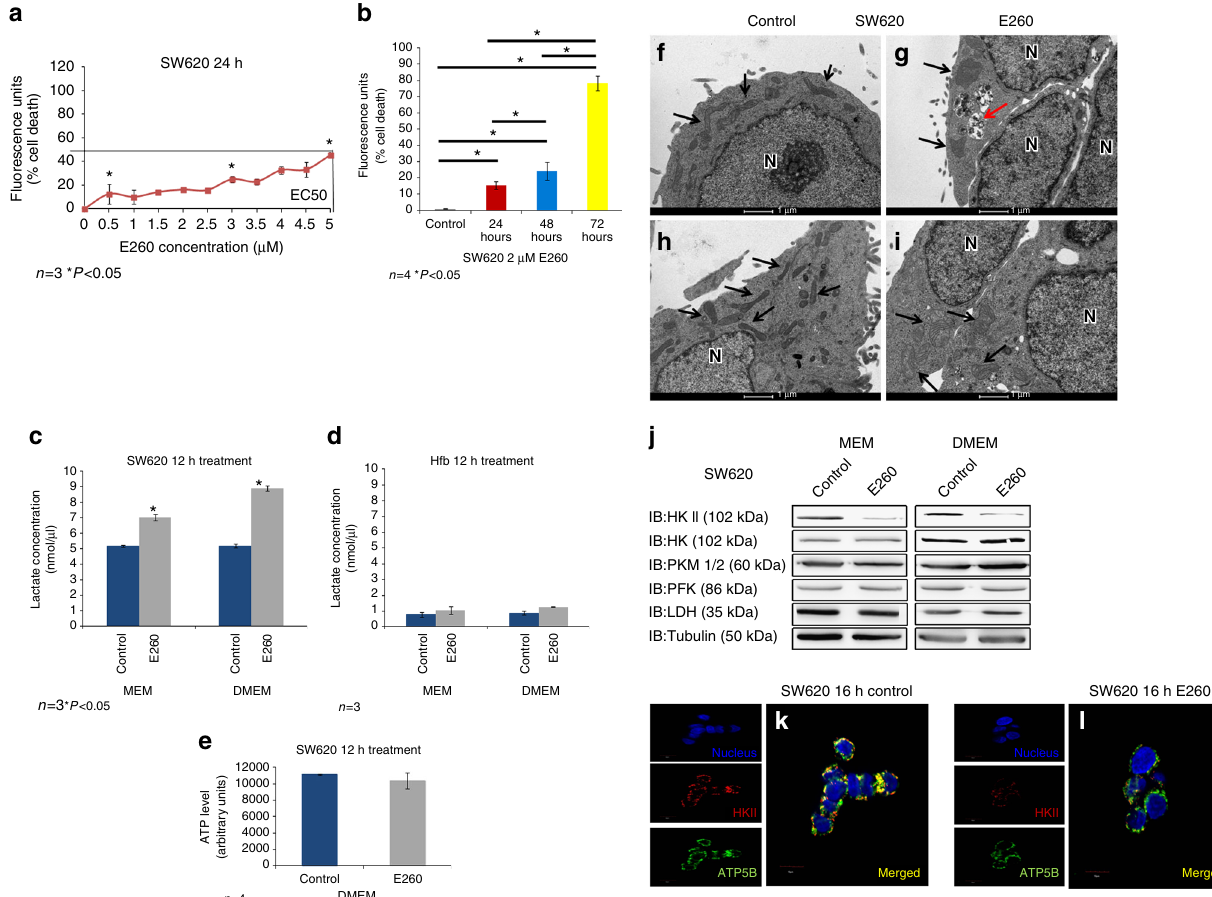
Fig. 6 Upregulated glycolysis and delayed onset of death in SW620 cells treated with E260 under high glucose conditions. a Death of SW620 cells grown in DMEM and treated with increasing concentrations of E260; n = 3, ± SE. b Death of SW620 cells grown in DMEM and treated with 2 µ M E260 for different periods of time; n = 4, ± SE. c Lactate levels secreted by SW620 cells grown either in MEM or DMEM and treated with control vehicle ( blue ) or 2 µ M E260 ( gray ) for 16 h. d Lactate levels secreted by Hfb grown either in MEM or DMEM and treated with control vehicle ( blue ) or 2 µ M E260 ( gray ) for 16 h. e ATP content in SW620 cells grown in DMEM and treated with control ( blue ) or 2 µ M E260 ( gray ) for 12 h; n = 4, ± SE. f – i TEM analysis of SW620 cells grown in DMEM and treated with control vehicle f , h , or 2 µ M E260 g , i for 24 h. Black arrows depict mitochondria. Red arrow points to autophagosomes. Bars represent 1 µ m. N nucleus. j Protein lysates prepared from SW620 cells grown in MEM or DMEM and treated with control vehicle or E260 for 16 h, were subjected to WB analysis with antibodies directed toward selected glycolytic enzymes. SW620 cells treated with control vehicle ( k ) or 2 µ M E260 ( l ) for 16 h were subjected to immunostaining using anti-HKII ( red ), and anti-ATP5B ( green ) antibodies. Nuclei were visualized with Hoechst ( blue ). Bars represent 10 µ m. Separated channels are presented to the left of the merged images. Yellow color indicates